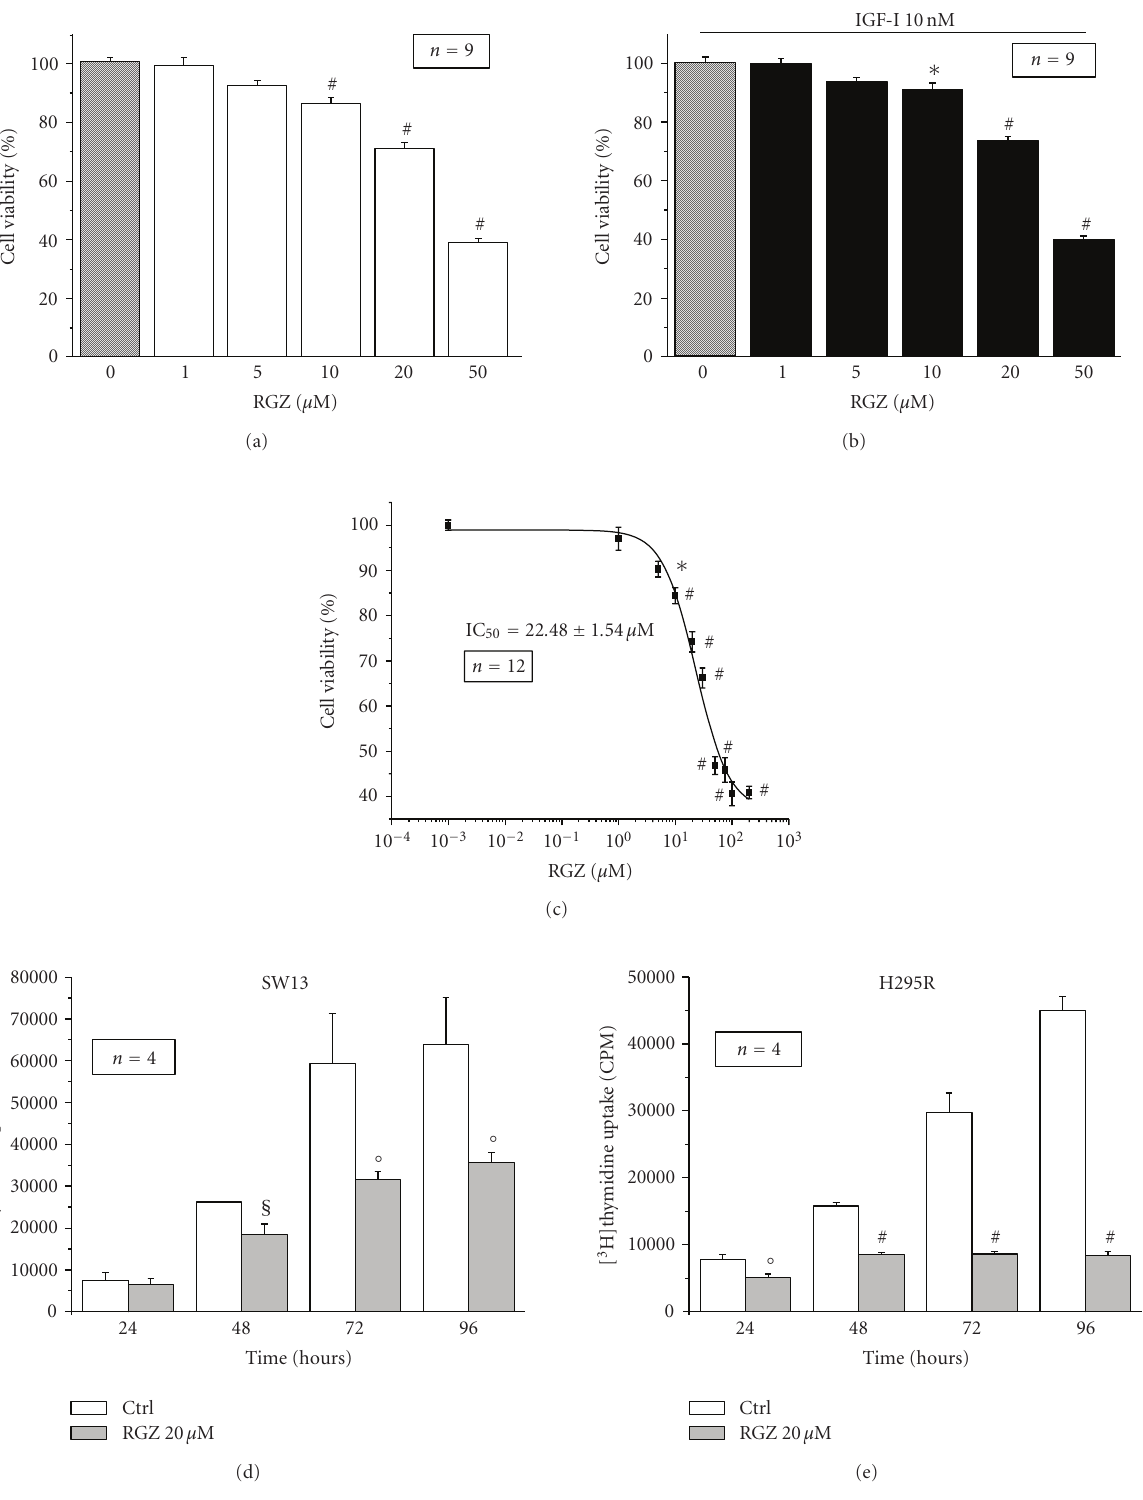
Figure 2: Dose dependent e ff ects of RGZ on adrenocortical carcinoma cell proliferation . The dose dependent e ff ect of RGZ on SW13 cell proliferation was evaluated by MTS assay at 48-hour stimulation in the absence (a), (c) or presence (b) of 10nM IGF-I. A complete dose response curve for RGZ (10 − 3 to 2 · 10 2 μ M) on cell proliferation in SW13 is reported (c), showing the IC 50 for RGZ calculated by ALLFIT program [17]. Data represent mean ± SE percentage of OD over controls (RGZ 0 μ M). Statistical significance versus respective control (RGZ 0 μ M): ∗ P < 0 . 05, # P < 0 . 001. The time dependent e ff ect of RGZ administration (20 μ M) on cell proliferation was evaluated at the indicated times in SW13 (d) and H295R (e) by [ 3 H]TdR incorporation. Data represent mean ± SE percentage of cpm over untreated control. Statistical significance versus respective Ctrl: ◦ P < 0 . 01, § P < 0 . 005, # P < 0 .